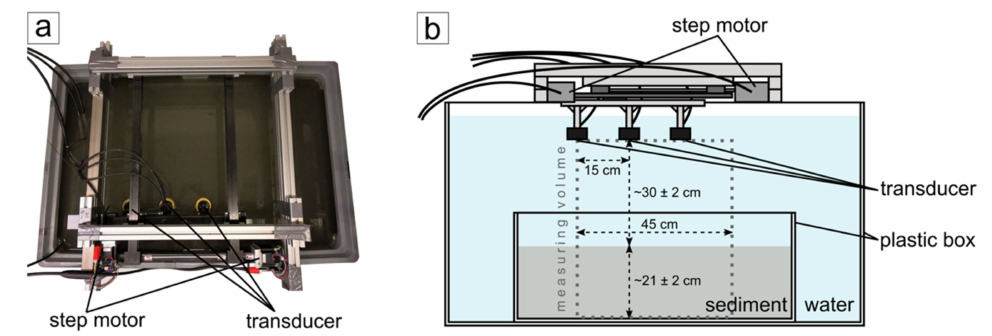
Figure 1. ( a ) Top-down photography of the test tank. The box filled with the substrate is not visible due to suspension in the water column. ( b ) The experimental setup consists of three transducers and two-step motors mounted on top of a water tank. The plastic box containing the buried test object is located 30 cm below the transducers and is filled with a 21 cm thick sediment